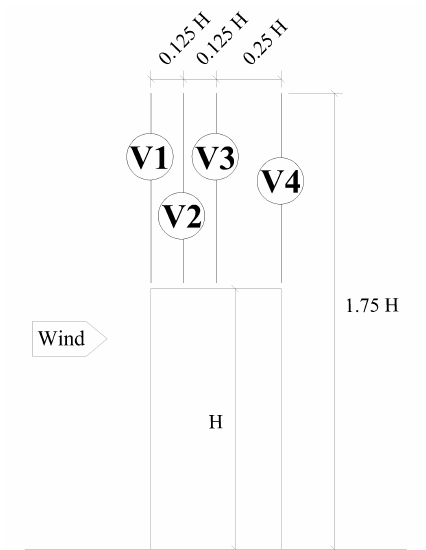
Figure 17. Diagram of the axes V1–V4 on the base-building at the central vertical plane of the domain, for the comparison of roof edge